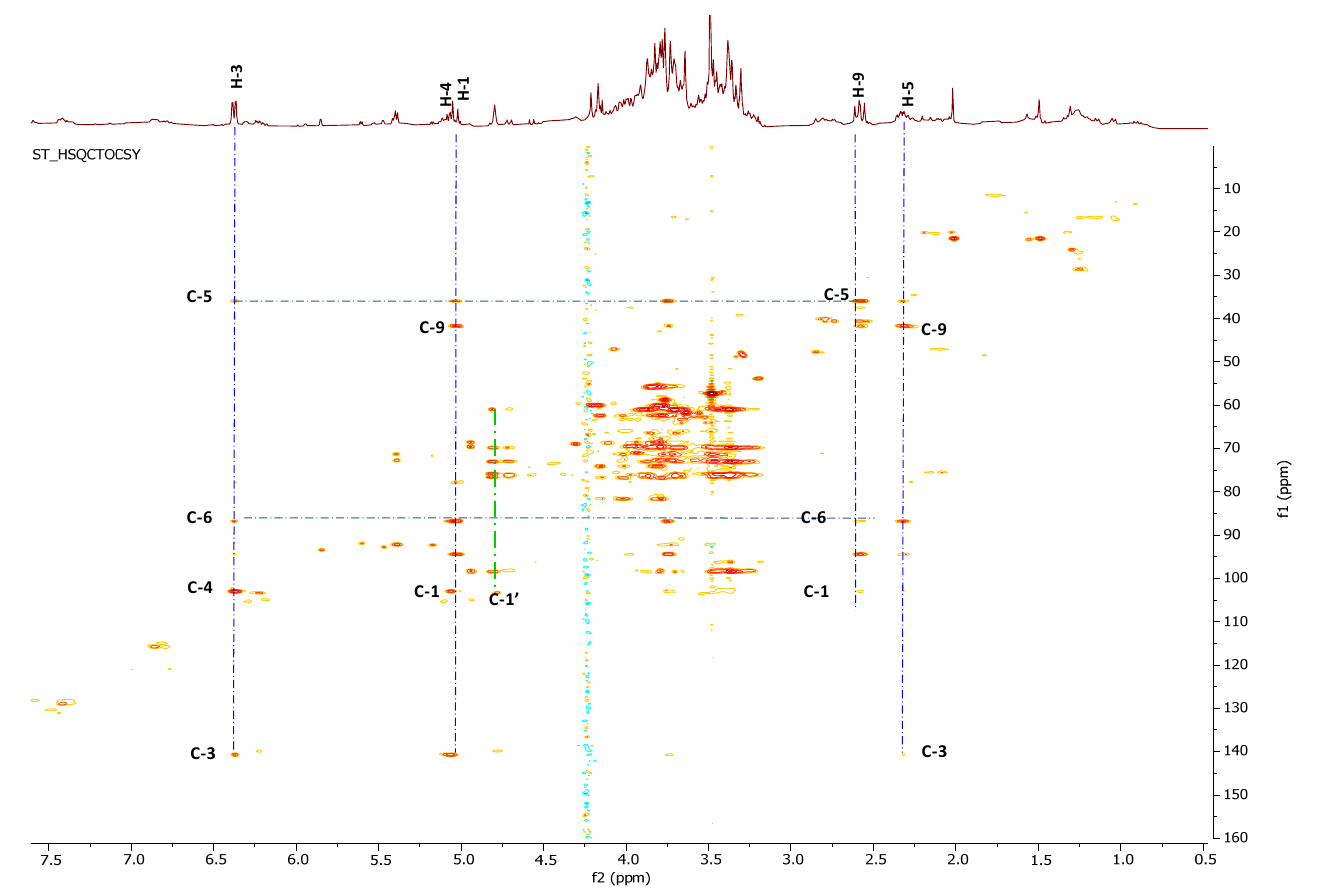
Figure 2. HSQC ‐ TOCSY and 1 H ‐ NMR spectra of S. trifoliata crude extract. Figure 2. HSQC-TOCSY and 1 H-NMR spectra of S. trifoliata crude